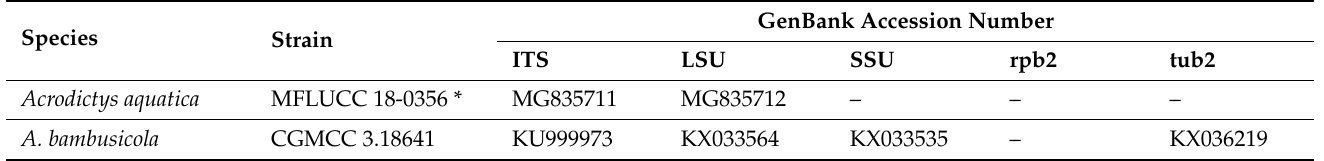
Table 2. Strains and GenBank accession numbers used in this